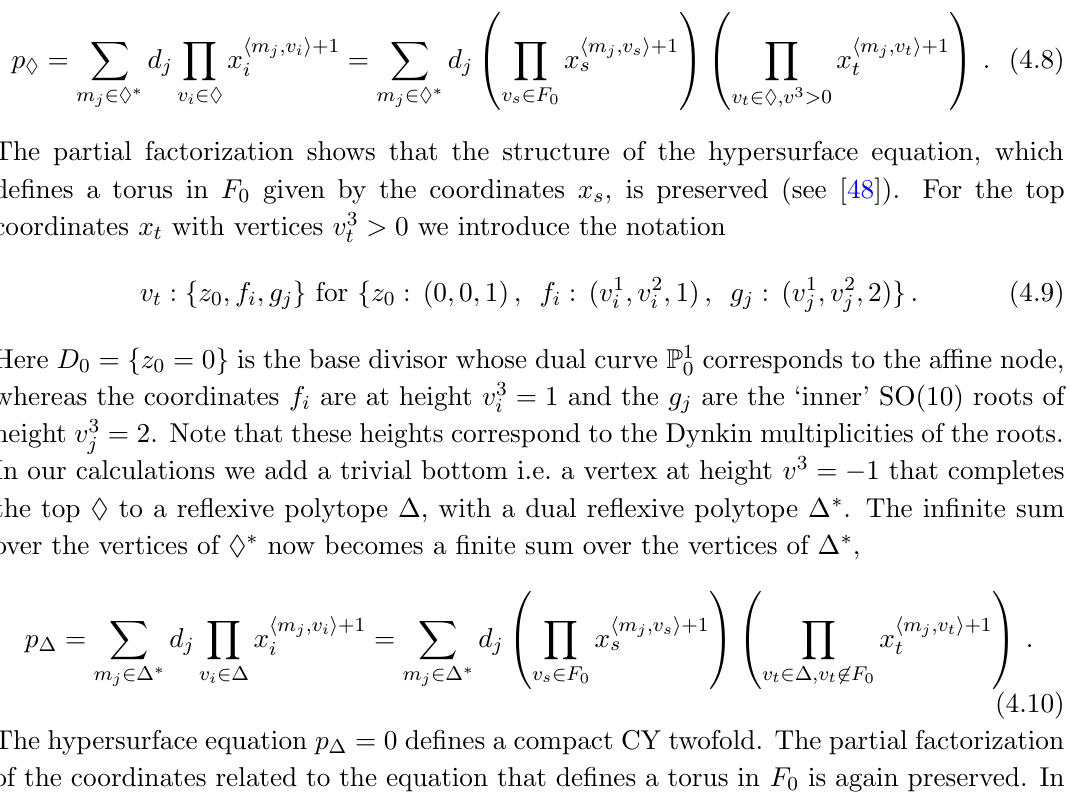
Figure 15 . Example ( F 3 , top 1). The dual prism is given in a) with F in green); b) depicts the top polytope with F 3 at height 0 (shaded in green); c) is a 2d projection of b) where blue circles denote vertices at height 1 and red squares vertices at height